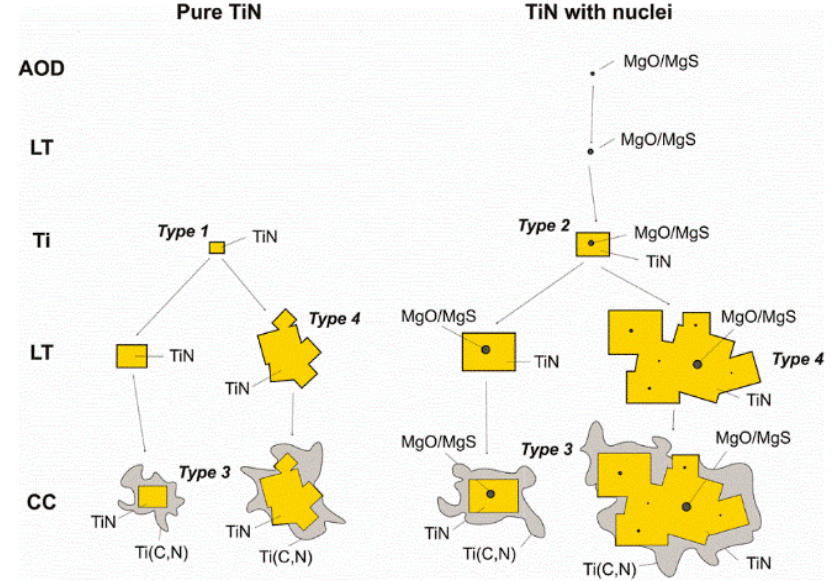
Figure 8. Schematic development of various TiN-morphologies over the process (AOD: tapping AOD-converter, LT: ladle treatment, Ti: Ti-addition, CC: continuous casting) [35].